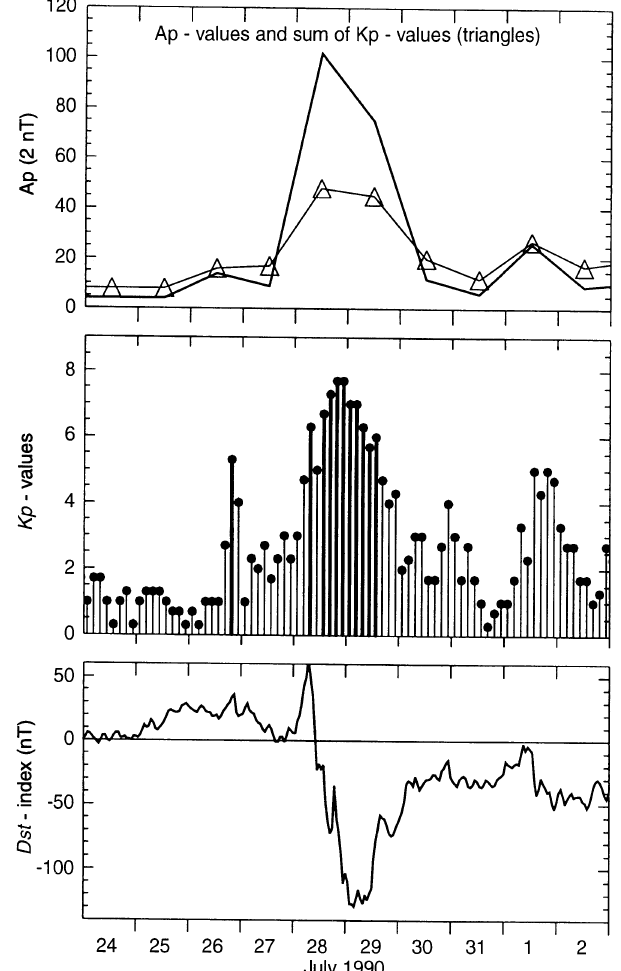
Fig. 1. Geophysical conditions during the time-interval under